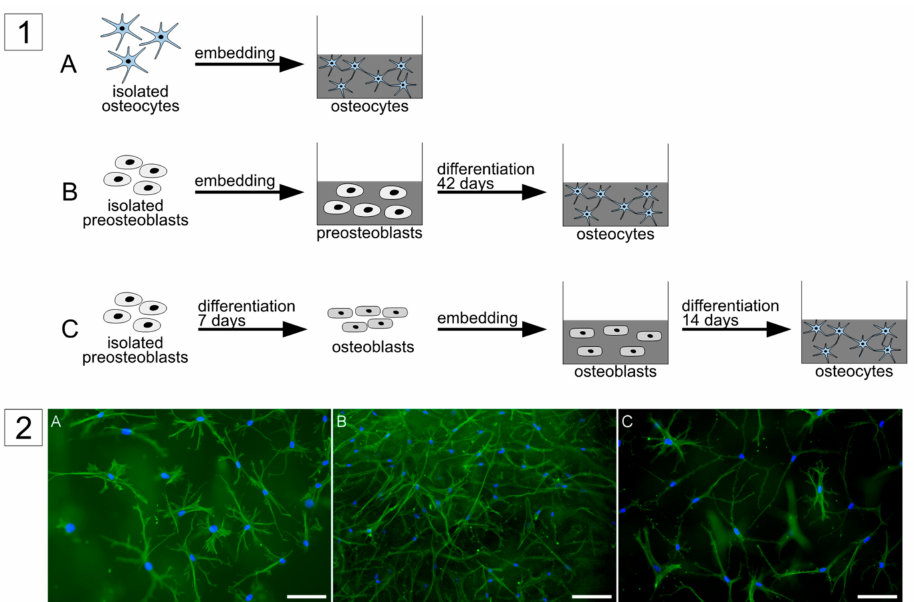
Figure 1. ( 1 ) Schematic diagram of di ff erent approaches to obtain primary human osteocytes in collagen gels: ( A )freshlyisolatedhumanprimaryosteocyteswereembeddedfor2daysincollagengel, ( B )human pre-osteoblasts were embedded in collagen gel and cultivated for 6 weeks, ( C ) human pre-osteoblasts were di ff erentiated using dexamethasone, ascorbic acid 2-phosphate, and β -glycerophosphate for 7 days on tissue culture polystyrene (TCPS) before embedding them in collagen gels for another 14 days. ( 2 ) Fluorescence images of osteocytes in collagen gels after staining the cytoskeleton (Alexa 488, green) and nuclei (DAPI (4 (cid:48) ,6-diamidin-2-phenylindol, Invitrogen), blue). Scale bar represents 100 µ m.